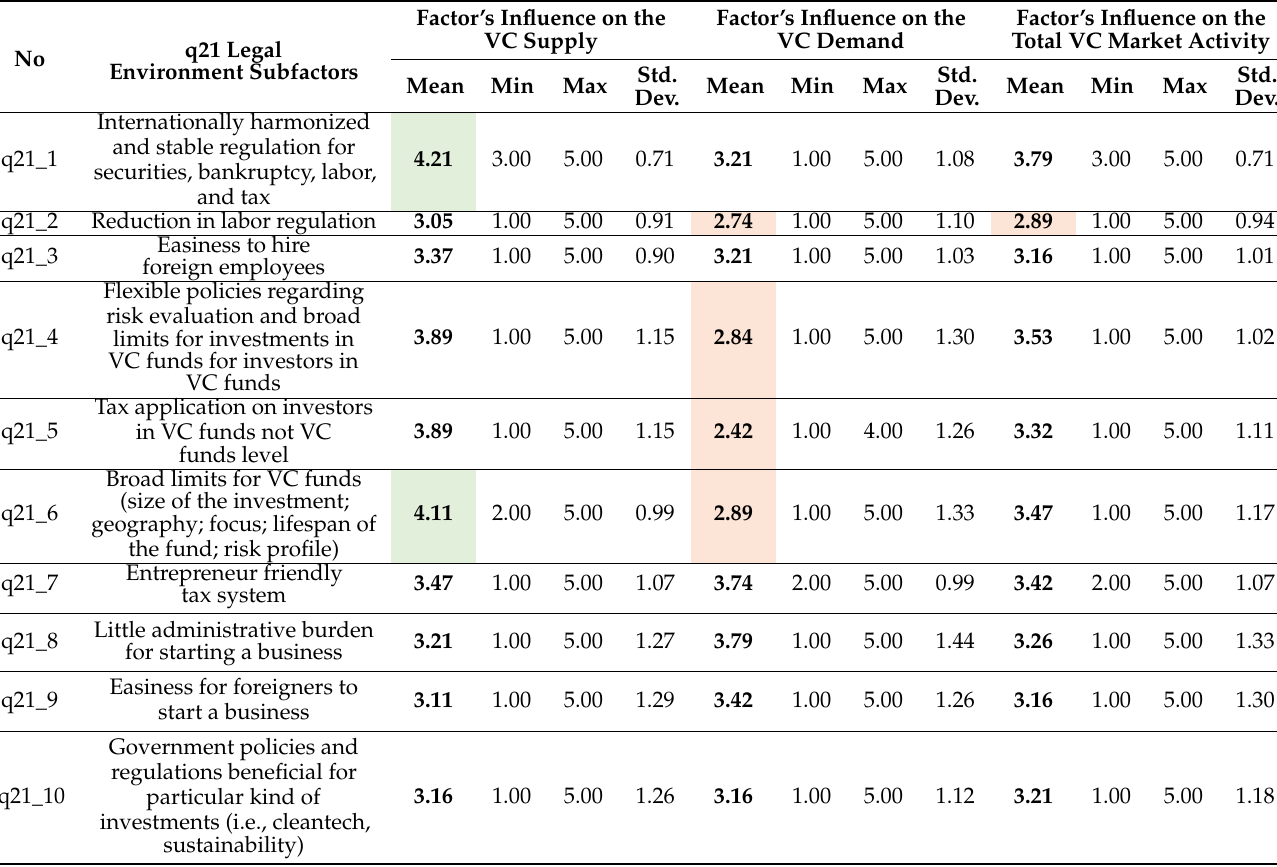
Table 11. The subfactors related to legal environment.